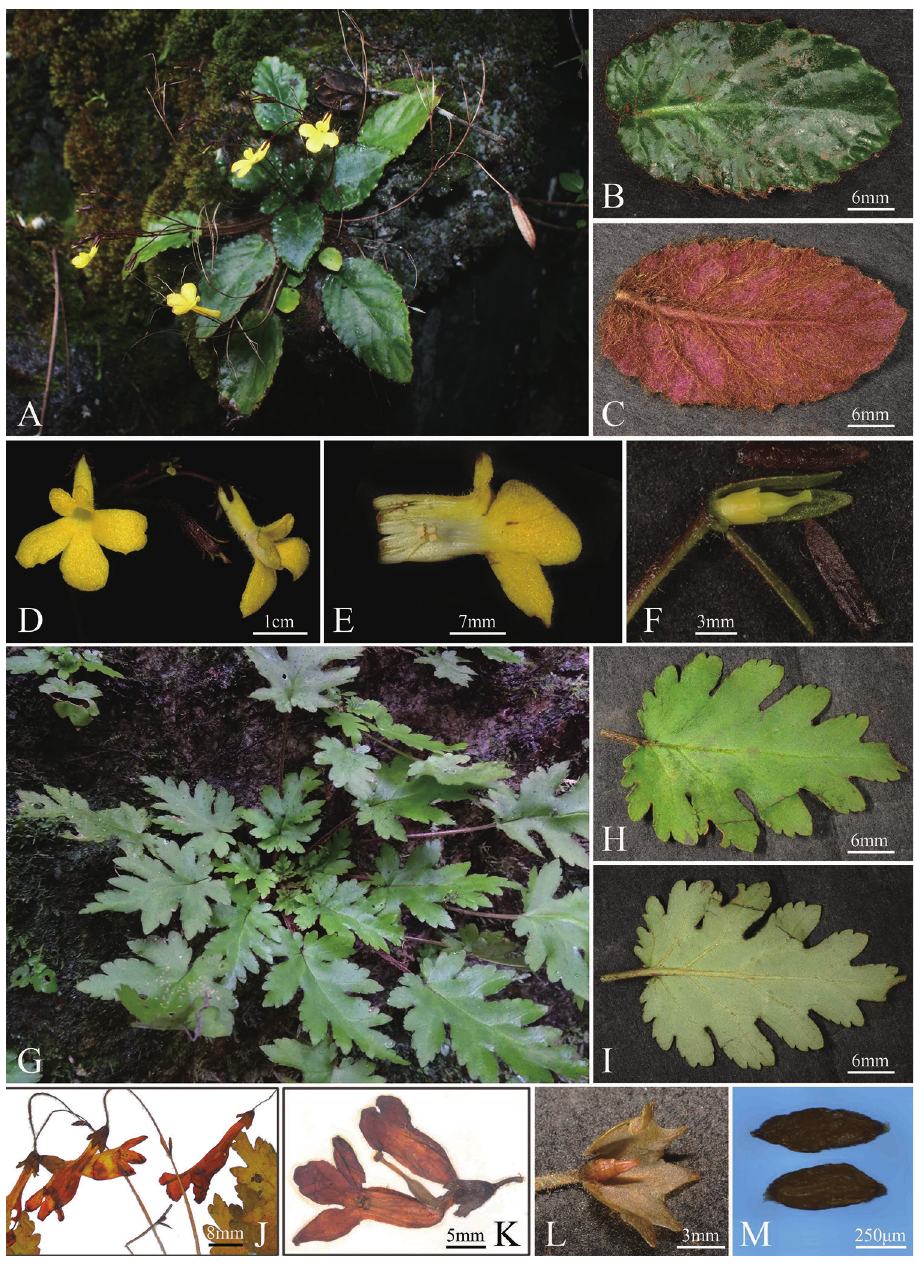
Figure 3. Oreocharis fulva W.H.Chen & Y.M.Shui, sp.nov. ( A–F ) A habitat B leaf abaxial surface C leaf abaxial surface D flower E open corolla F calyx and ovary; O. lacerata ( G–M ) G plant H leaf adaxial surface I leaf abaxial surface J lateral view of flower K lateral opened flower L disc and ovary M seeds. Photography by Li Yong-Liang ( A, G ), Shui Yu-Min ( B–G, H, I, L ), Chen Li ( J–M